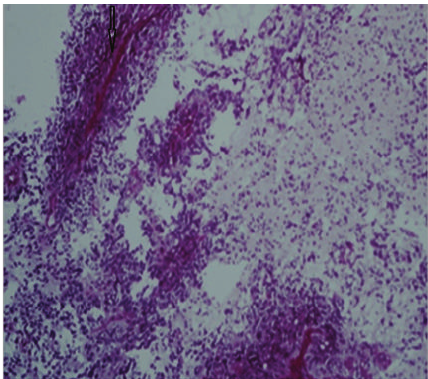
Figure 3: Histological section of ovary. Highly cellular tumor composed of small cells with hyperchromatic, round-to-oval nuclei, and scanty cytoplasm. Perivascular pseudorosettes (as depicted in the figure by an arrow mark), ependymal rosettes, and extensive